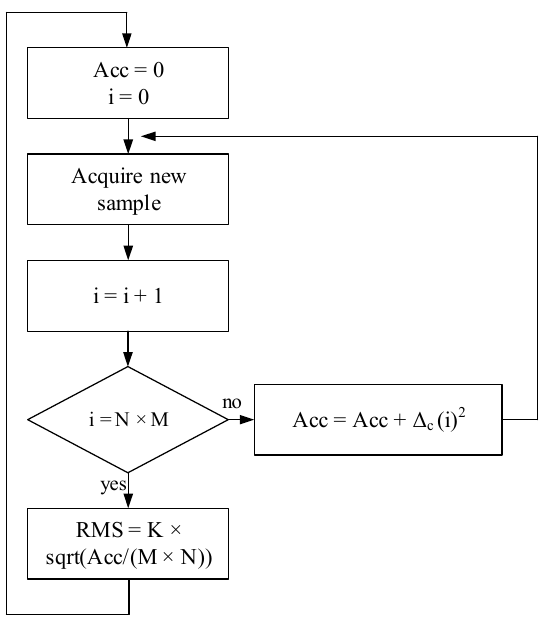
Figure 6. The flowchart of RMS implementation.